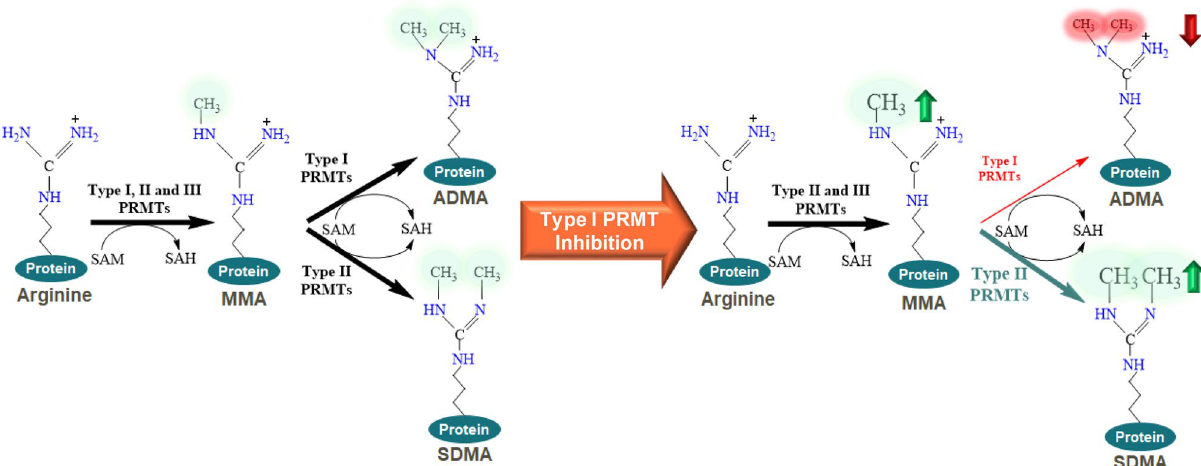
Figure 1. Pharmacology of arginine methylation with type I PRMT inhibition. Schematic of arginine methylation mediated by PRMTs and mechanism of type I PRMT inhibition. The left side of the figure shows normal arginine methylation and the right side illustrates the decrease in ADMA with a concomitant increase in MMA and SDMA upon type I PRMT